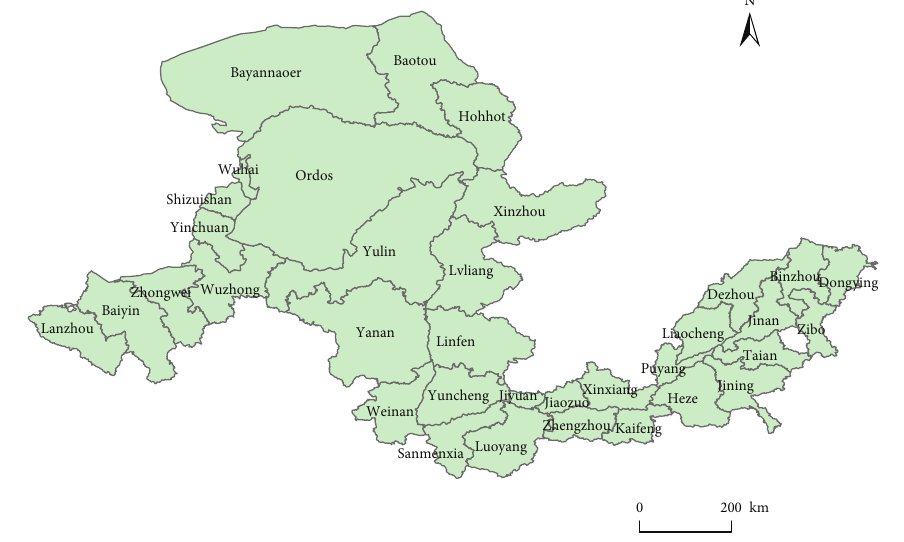
Figure 1: Topographic map of YRB and sample of this paper.